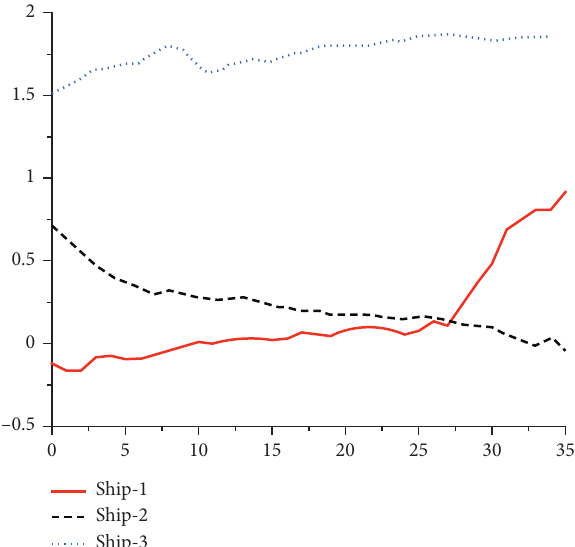
Figure 32: Change curve of collision risk during collision avoidance.